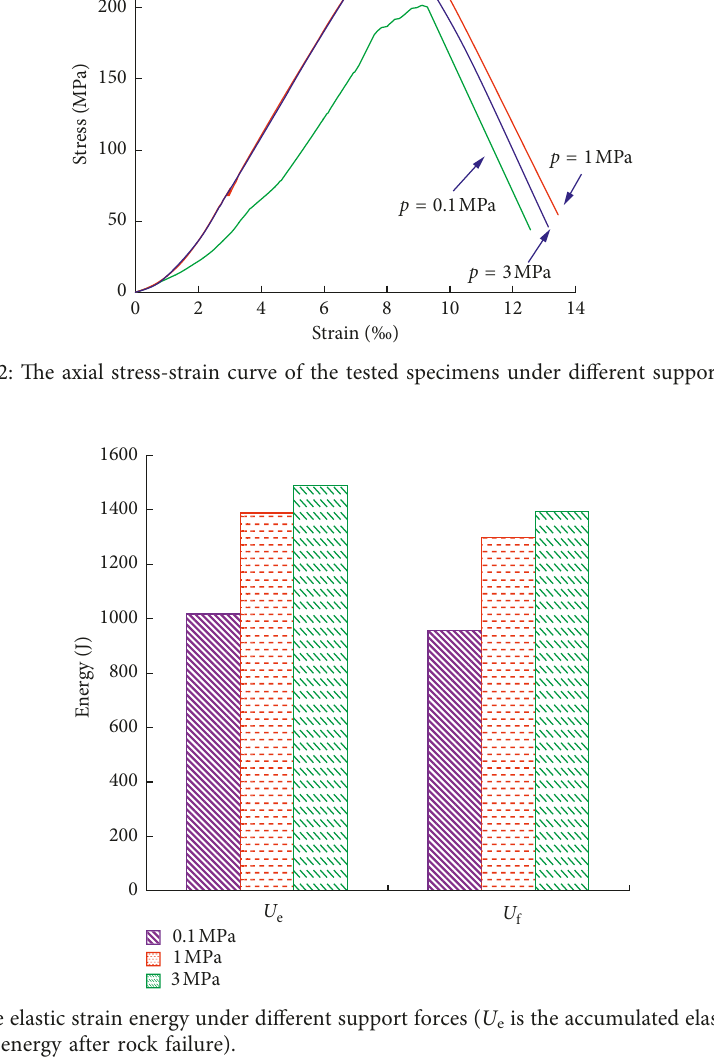
e is the accumulated elastic strain energy before rock